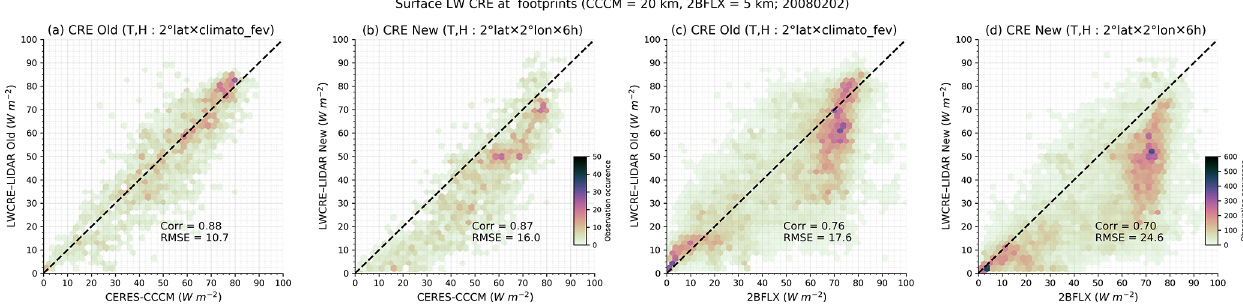
Figure 17. Distribution of the surface LW CRE: (a) LWCRE–LIDAR retrieved using monthly mean temperature/humidity profiles as a function of CERES-CCCM with data at 20km resolution (CERES SSF footprint); (b) same as (a) but LWCRE–LIDAR retrieved using sub-daily temperature/humidity profiles; (c, d) same as (a, b) but for 2BFLX instead of CERES-CCCM and using data at 5km resolution (CloudSat